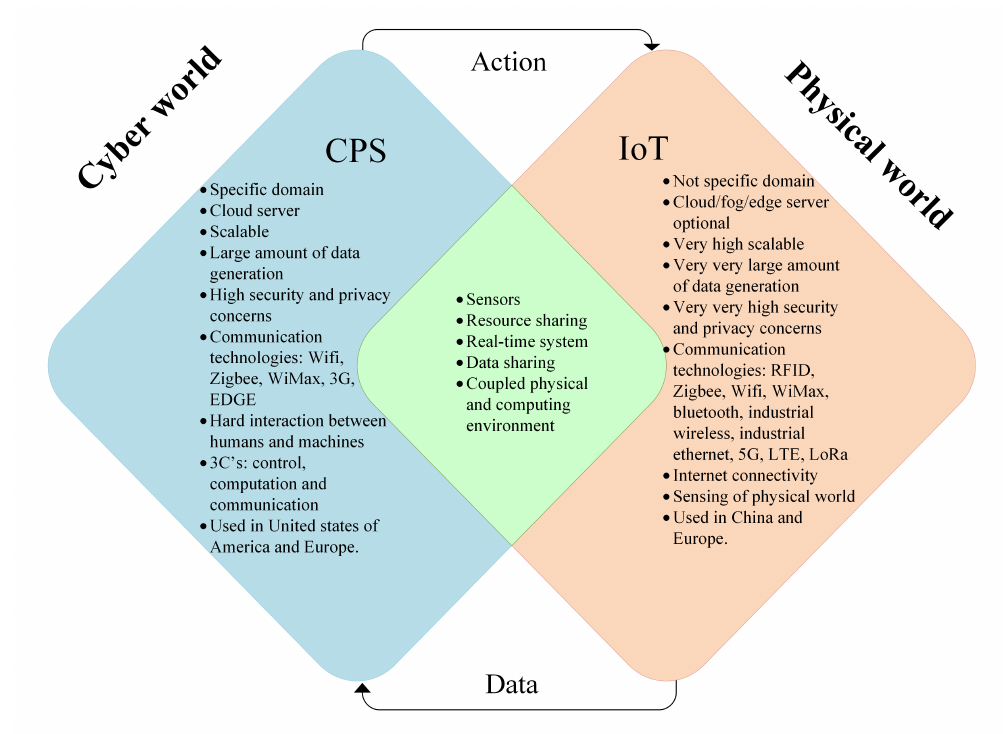
Figure 5. Comparison of CPS and IoT; supporting Industry 4.0